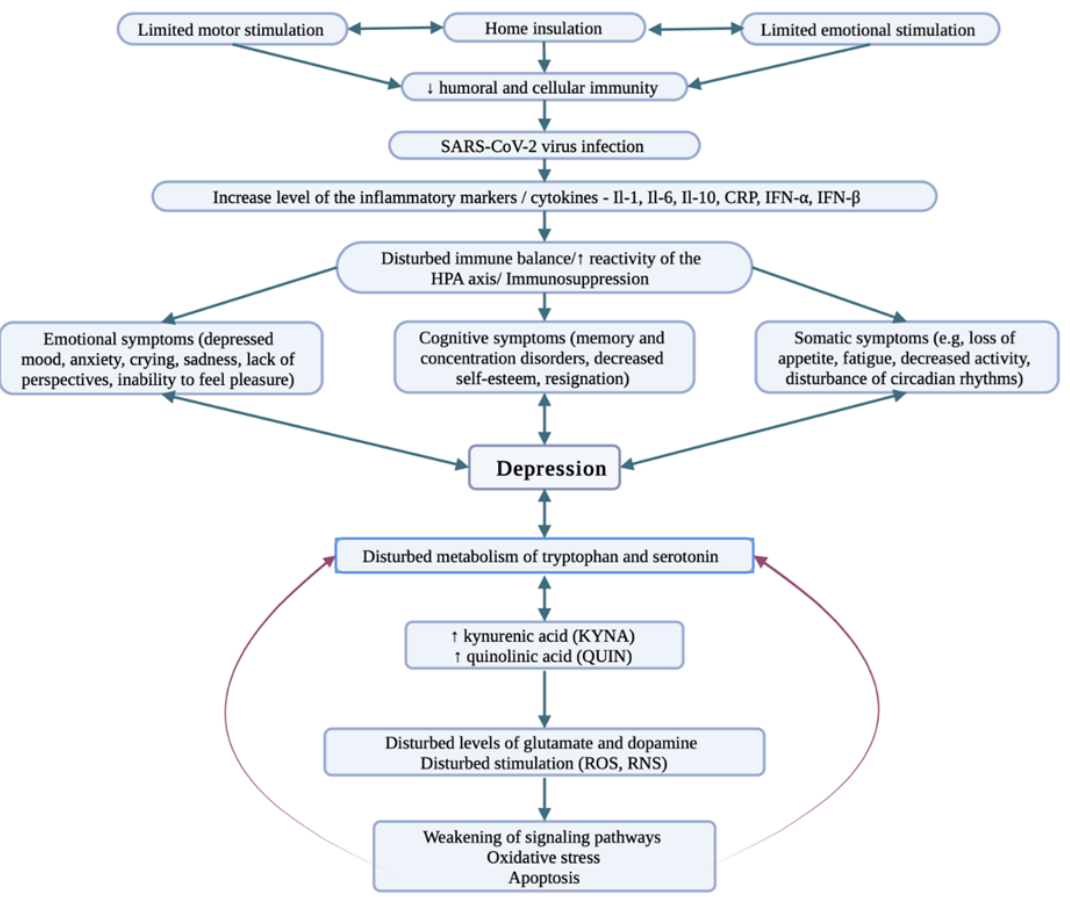
Figure 1. Depression — a pattern of neurochemical changes induced by SARS-CoV-2 [73 – 75]. Social isolation due to the possibility of SARS-CoV-2 virus infection decreases emotional and motor arousal resulting in decreased immunity. Consequently, the body is more susceptible to infections, including COVID-19 infection. When an infection occurs, inflammatory markers/cytokines increase in the body, leading to immunosuppression. Disturbed immune coordination causes discomfort to the entire body resulting in somatic, emotional, and cognitive symptoms, and the metabolism of neurotransmitters and their metabolites is impaired. The consequence is impairment of signaling pathways and development of